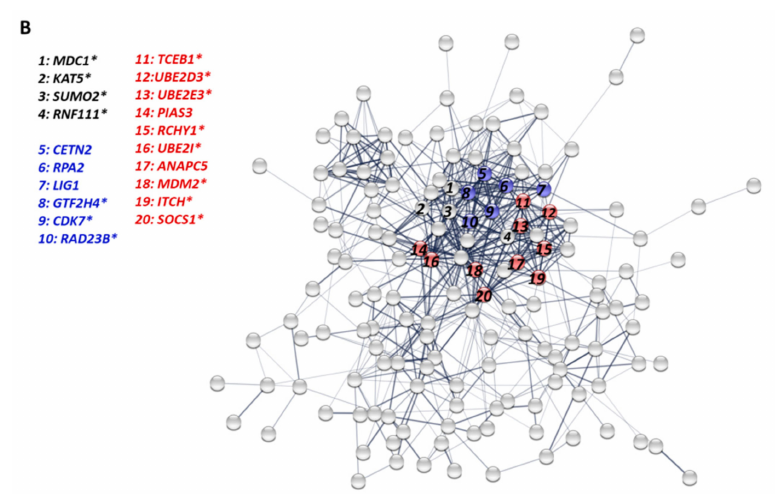
Figure 5. Protein-protein interaction (PPI) networks of DEGs in peripheral blood mononuclear cells isolated from infected calves. ( A ) The PPI network enriched with up-regulated DEGs in P1 group versus mock-infected group. The red circles and fonts represent the genes associated with the pathway of bacterial invasion of epithelial cells; green circles and fonts, Fc gamma R-mediated phagocytosis; blue circles and fonts, oxidative phosphorylation; pink circles and fonts, Th 17 cell di ff erentiation pathway. * means the top 15 genes with the most connectivity in the PPI network. ( B ) The PPI network enriched with up-regulated DEGs in P150 group versus mock-infected group. The red circles and fonts represent the genes associated with the pathway of ubiquitin-mediated proteolysis; blue circles and fonts, genes associated with nucleotide excision repair; * means the top 15 genes with the most connectivity in the PPI